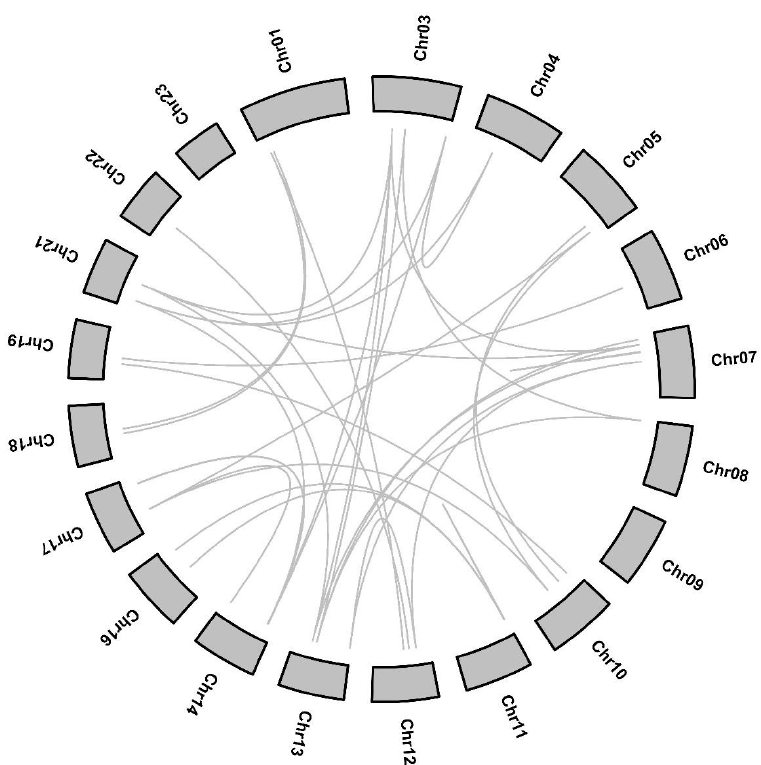
Figure 7. Gene duplication analysis among 50 Osmanthus fragrans auxin response factor genes ( OfARF s ).